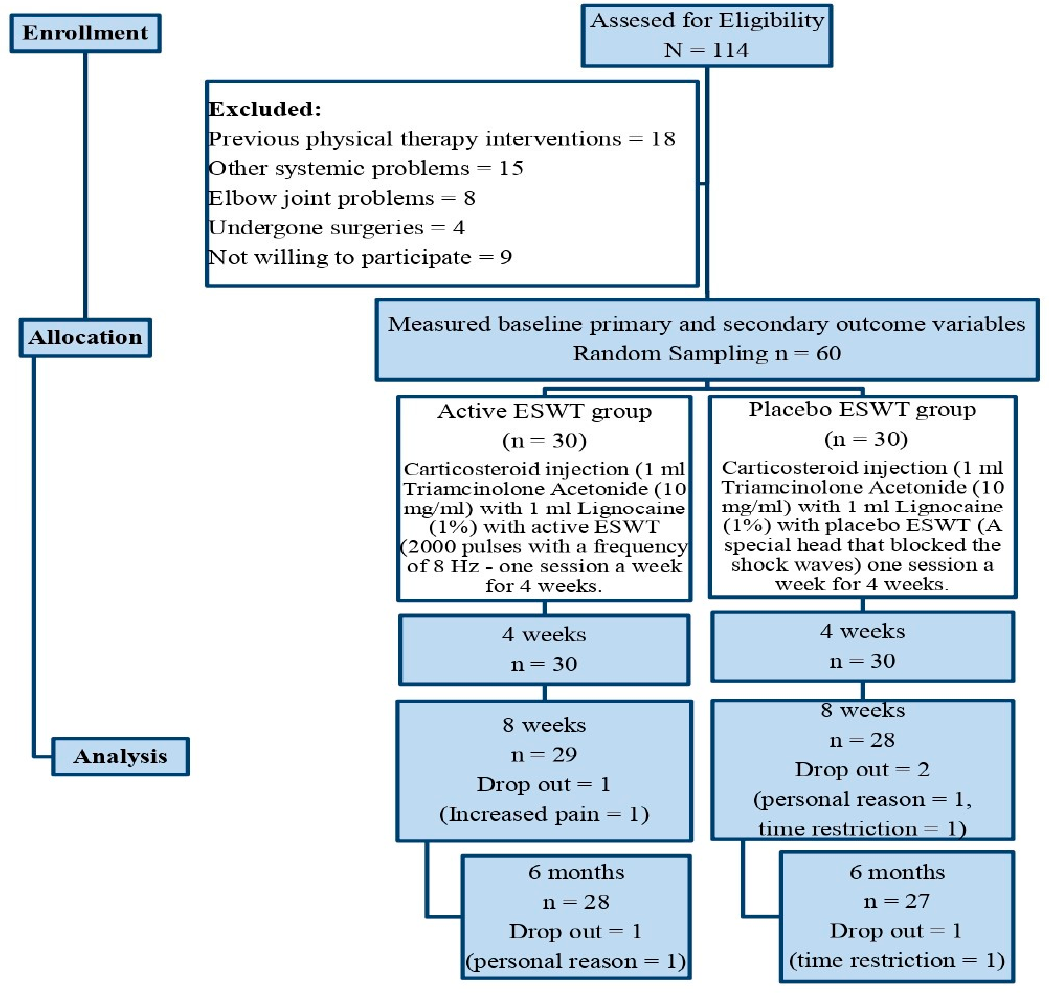
Figure 1. Flow chart showing the study details. Table 1. Demographic and clinical characteristics of active and placebo ESWT groups.